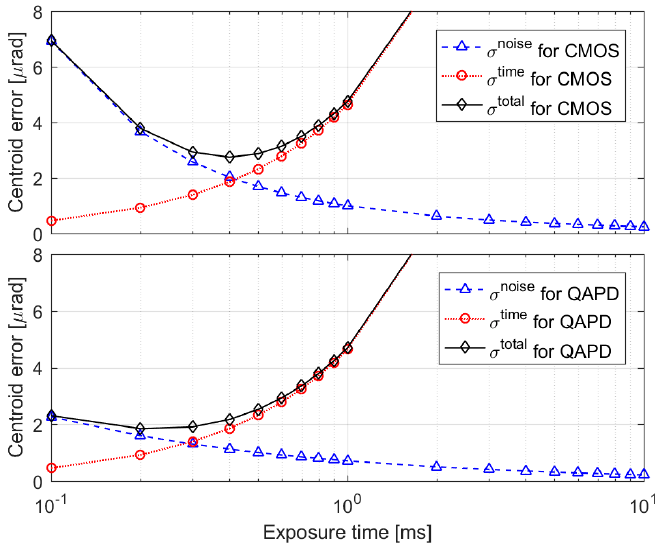
Figure 6. Total centroid error under moderate atmospheric turbulence conditions.